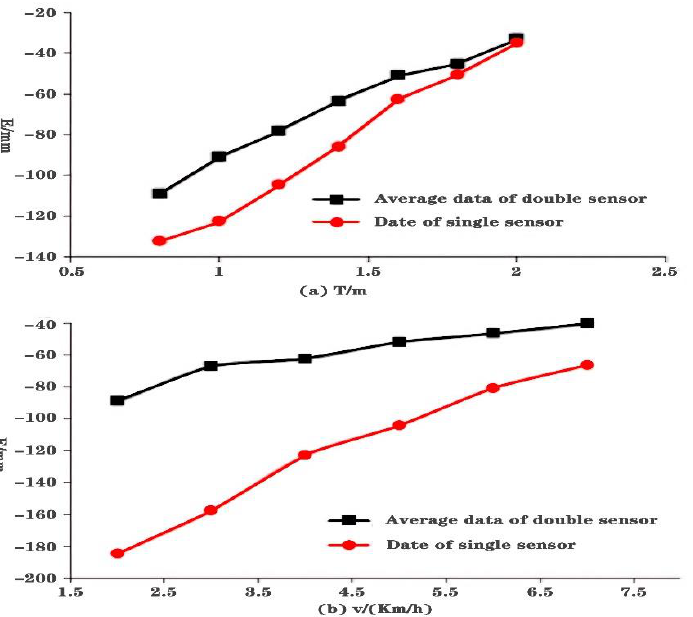
Figure 12. Results on single factor experiment: ( a ) Results on fixed driving speed, ( b ) Results on fixed cross range.